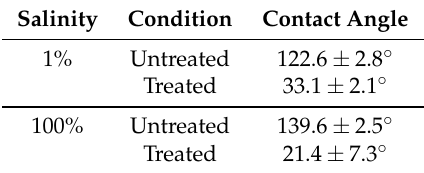
Table 1. Oil contact angle for treated and untreated glass slides, in the presence of Na 2 SO 4